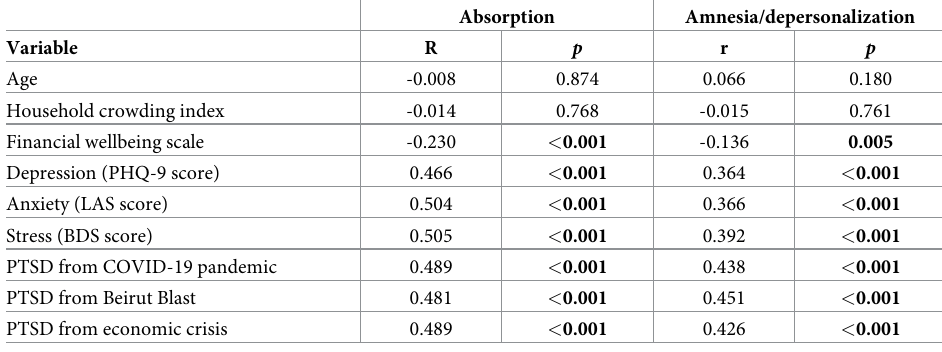
Table 3. Correlation between the dissociative experiences score and other continuous variables.